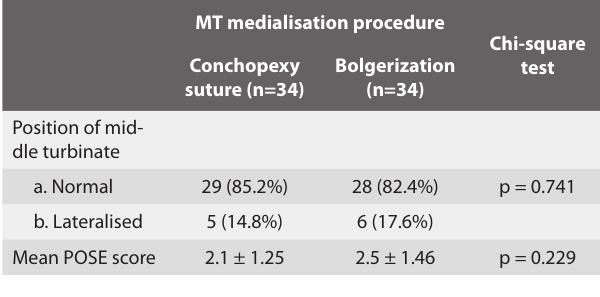
groups.Table Table 2. Position of middle turbinate and mean POSE score in both